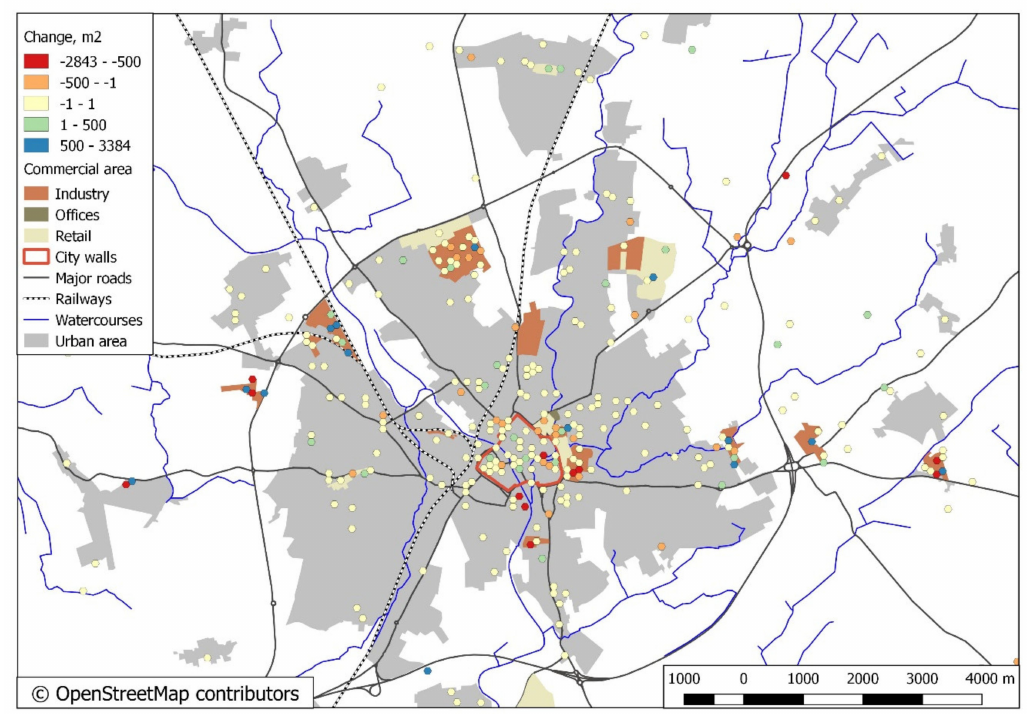
Figure 12. Change in industrial property floorspace distribution,